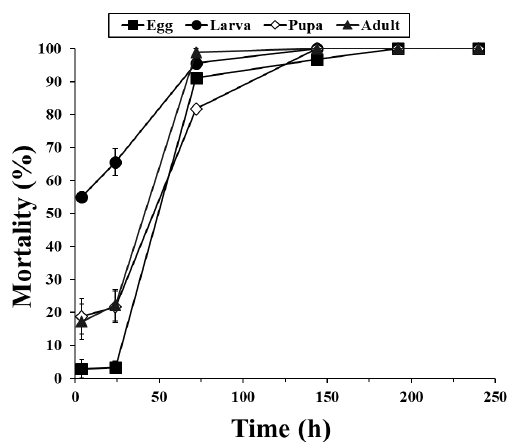
Figure 1. Mortality of ( A ), d ‐ strain Tribolium castaneum , ( B ), r ‐ strain T . castaneum and ( C ), Oryzaephilus surinamensis eggs, larvae, pupae and adults after 4 h of exposure to the PH 3 fumigant in a 12 ‐ L desiccator.